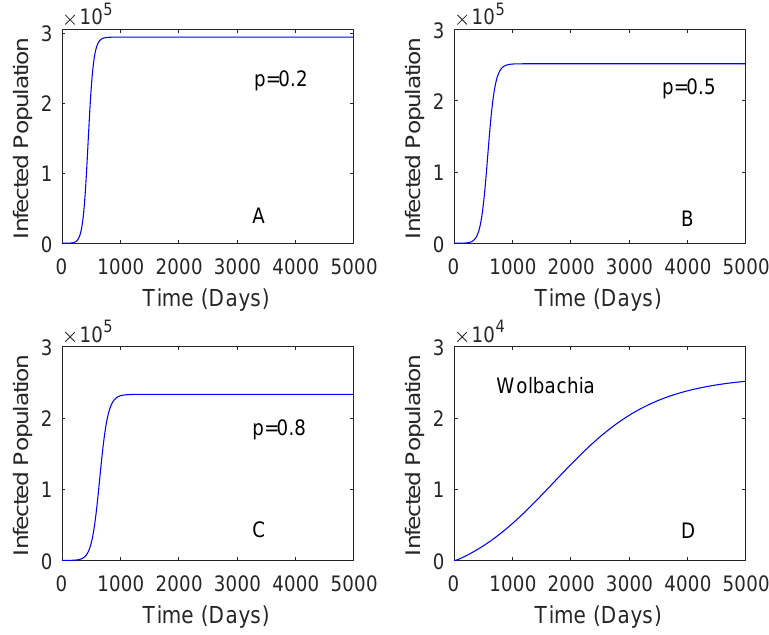
Figure 3. Comparing the performance of vaccination and Wolbachia with different vaccination rates. This is for the case R A = 2.91 and the vaccine efficacy is 0.536. The vaccination rates are 0.2 plot ( A ), 0.5 plot ( B ), 0.8 Plot ( C ). Plot ( D ) is for Wolbachia strategy.